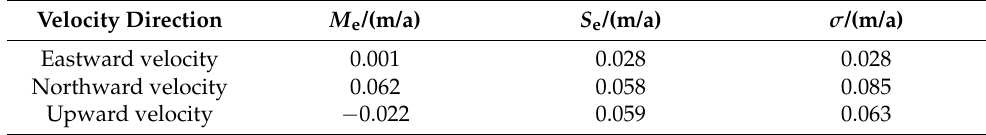
Table 2. Statistical results of non-glacial errors